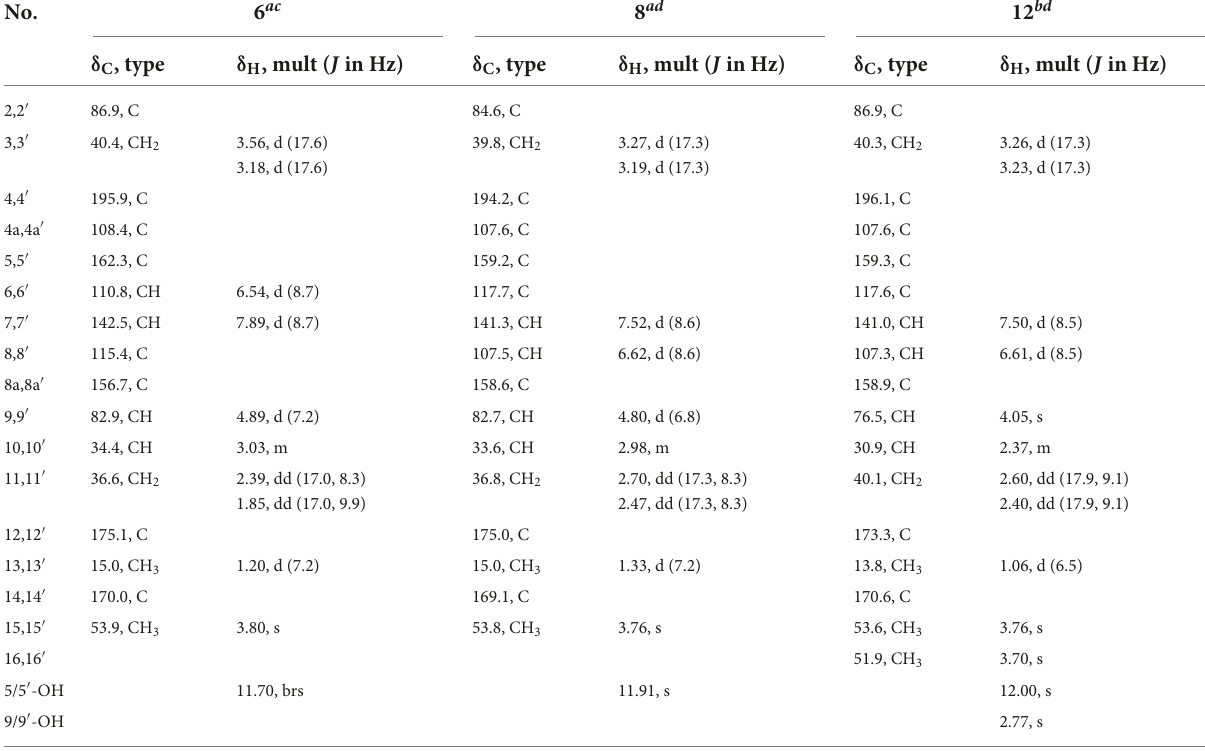
TABLE 3 1 H and 13 C NMR spectroscopic data of Compounds 6 , 8, and 12 (CDCl 3 ).